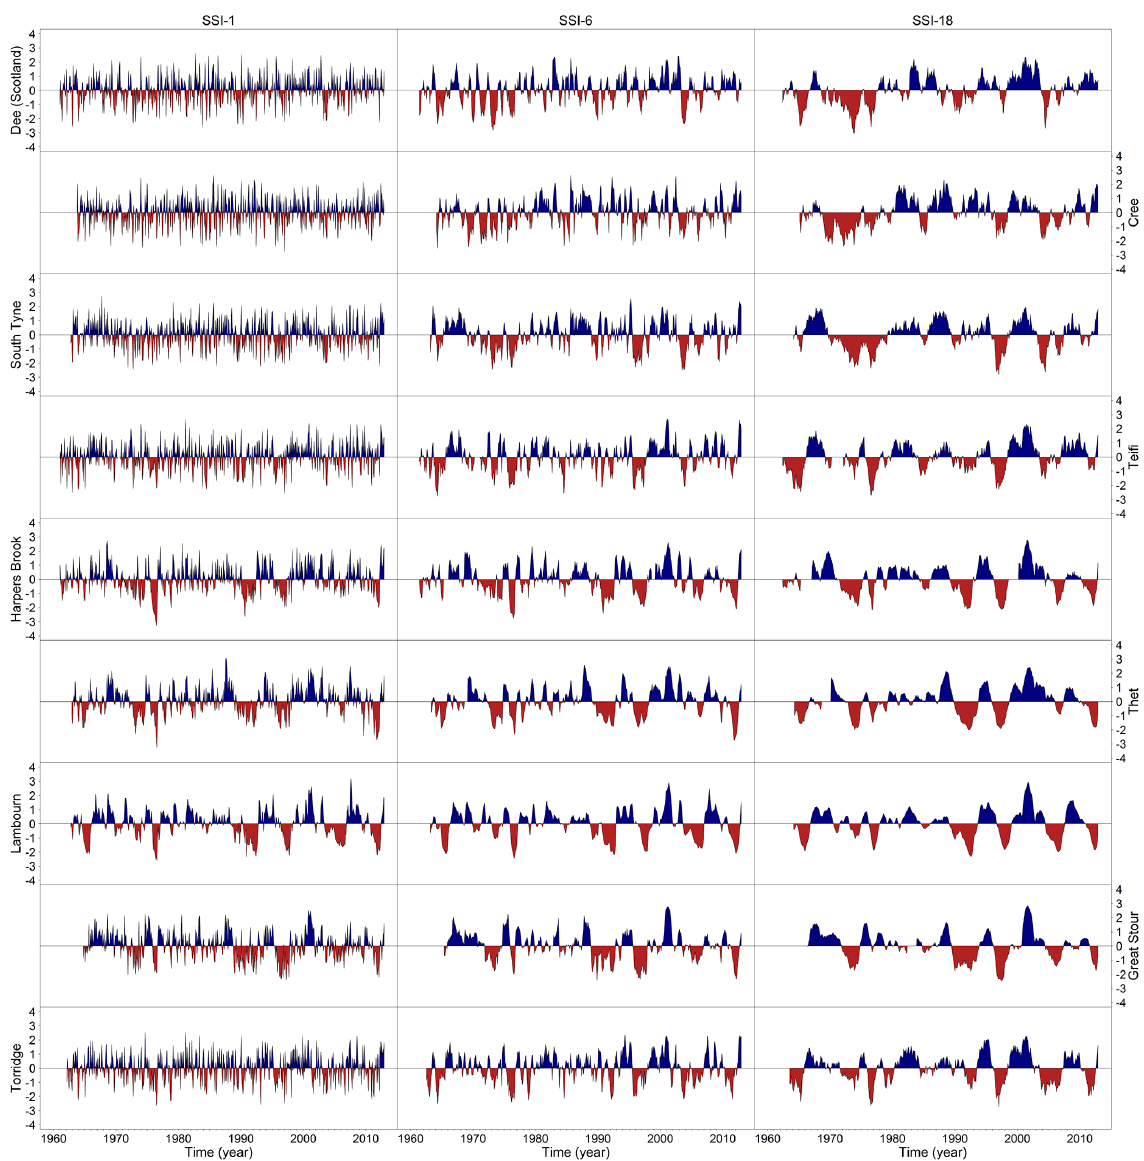
Figure 7. Case study catchment SSI time series for selected accumulation